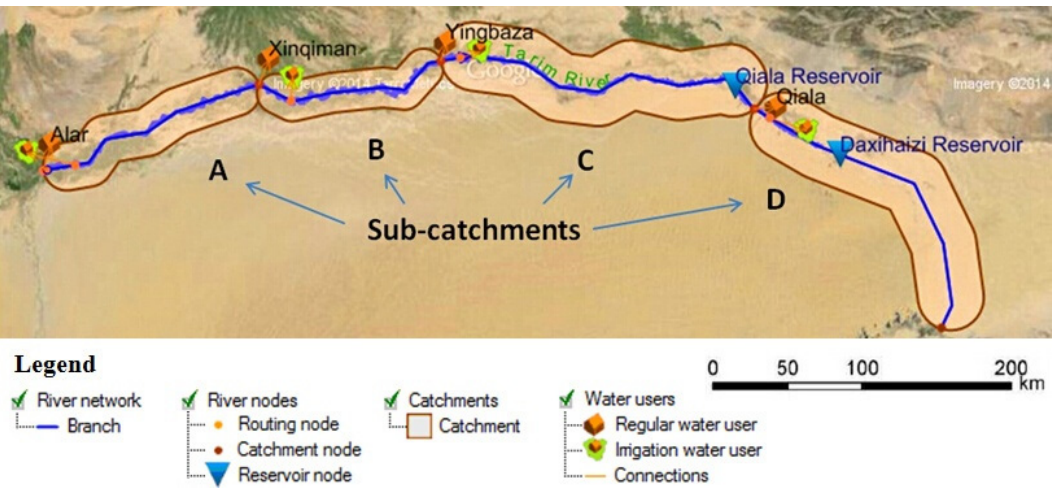
Figure 3. Sub-catchments in the main stem of Tarim River in MIKE